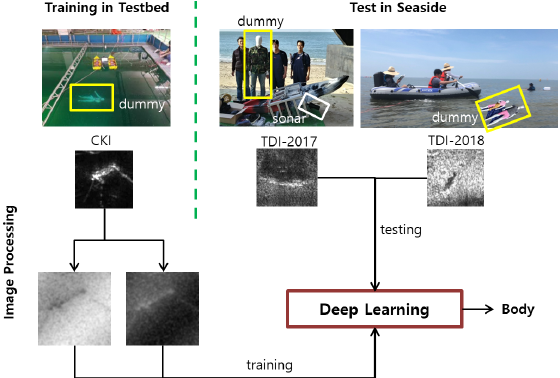
Figure 2. Overview of the proposed approach. We trained the model using CKI with image processing techniques and tested real seaside images of TDI-2017 and